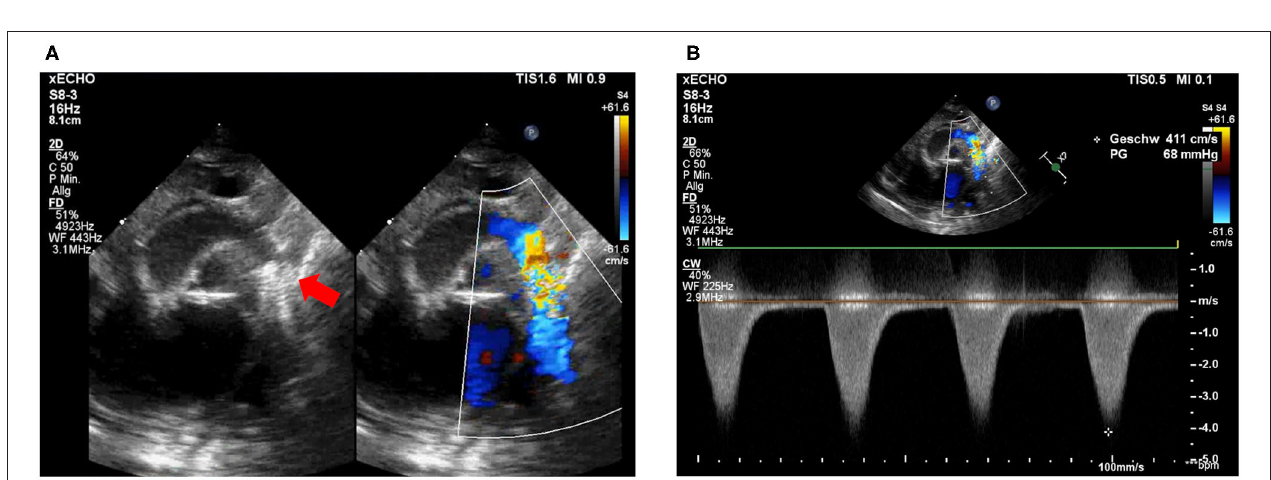
FIGURE 2 | Post-intervention echocardiography. (A) Stent visualization in the descending aorta. Proximal stent struts (red arrow) partially cover the opening of the left subclavian artery (LSA) without obstruction. (B) Flow acceleration over coronary stent in isthmus region with 4.1 m/s.